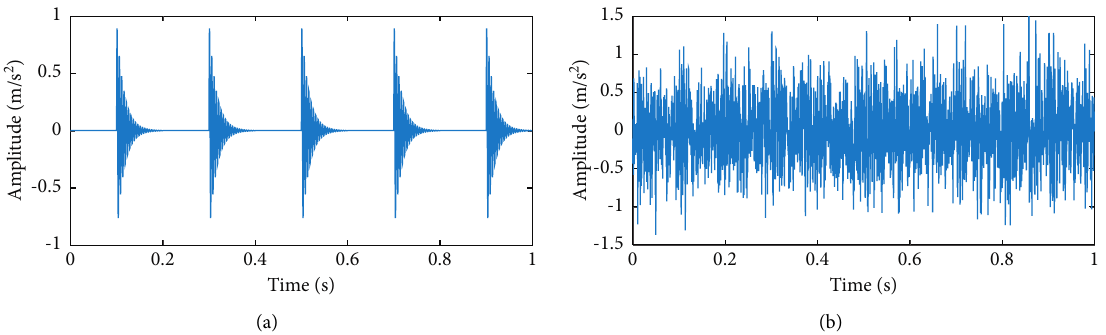
Figure 3: The simulation signal. (a) Cyclic unilateral attenuation simulation signal. (b) The noisy simulation signal.